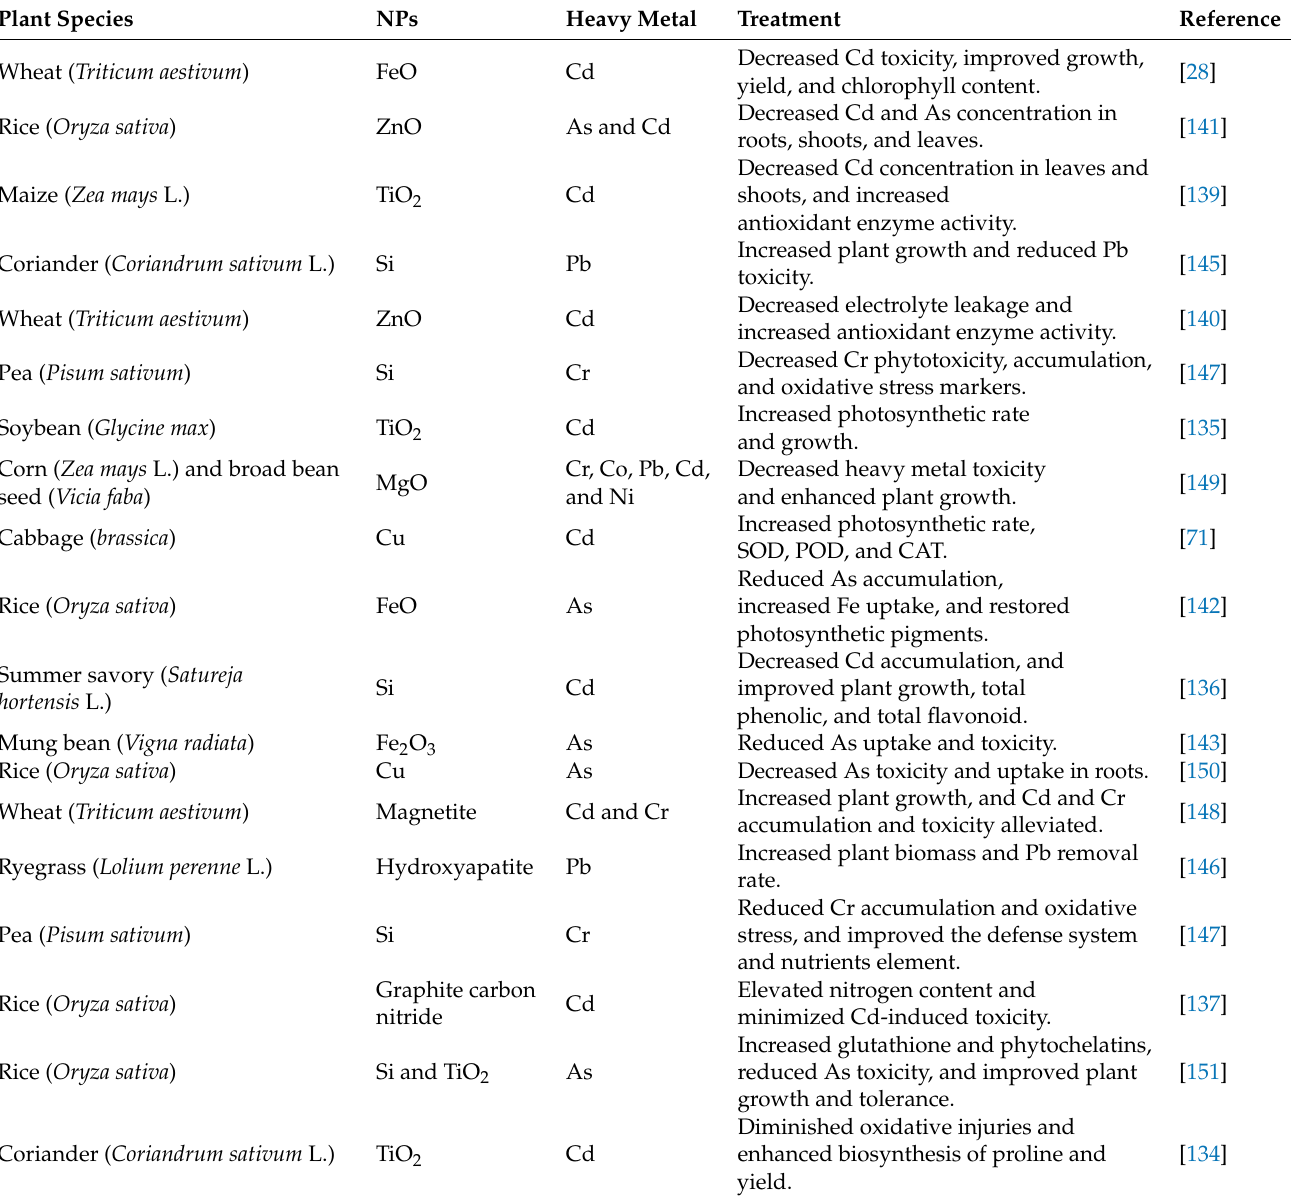
Table 3. Impact of NPs on plants under heavy metal